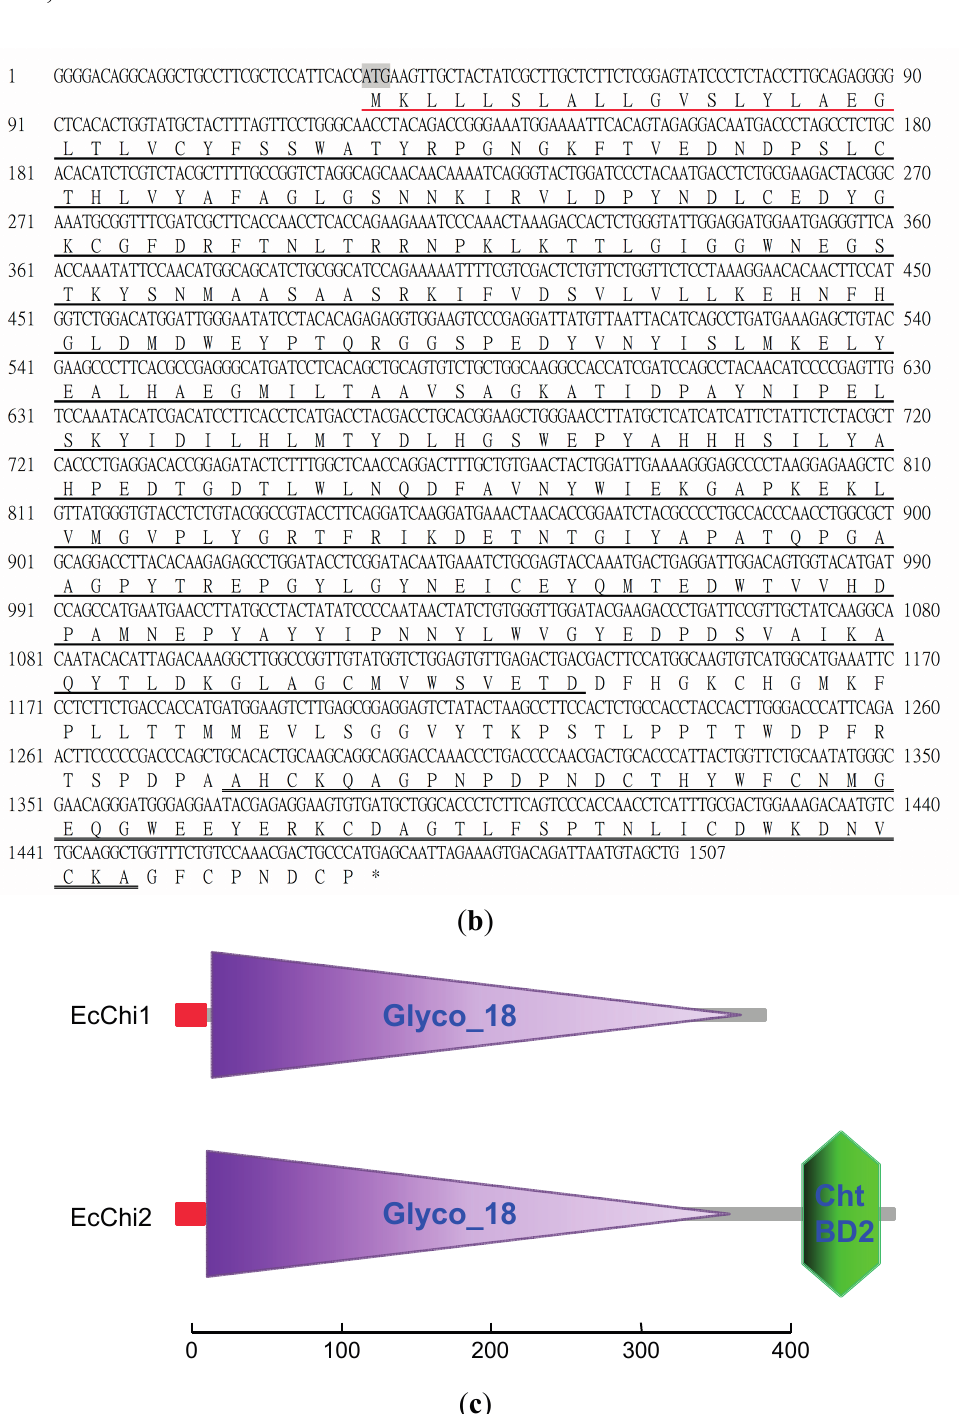
Figure 3. Nucleotide and deduced amino acid sequences of EcChi1 and EcChi2 genes. ( a ) EcChi1; the letters in shadow indicate initiation codon (ATG) and asterisk indicate termination codon (TAA). The signal peptide is underlined with a red single line, and the Glyco_18 domain is underlined with a black single line; ( b ) EcChi2; the letters in shadow indicate initiation codon (ATG) and asterisk indicate termination codon (TGA). The signal peptide is underlined with a red single line, and the Glyco_18 domain is underlined with a black single line, Cht BD2 is marked with a double underline; ( c ) Schematic representation of EcChi1 and EcChi2 protein